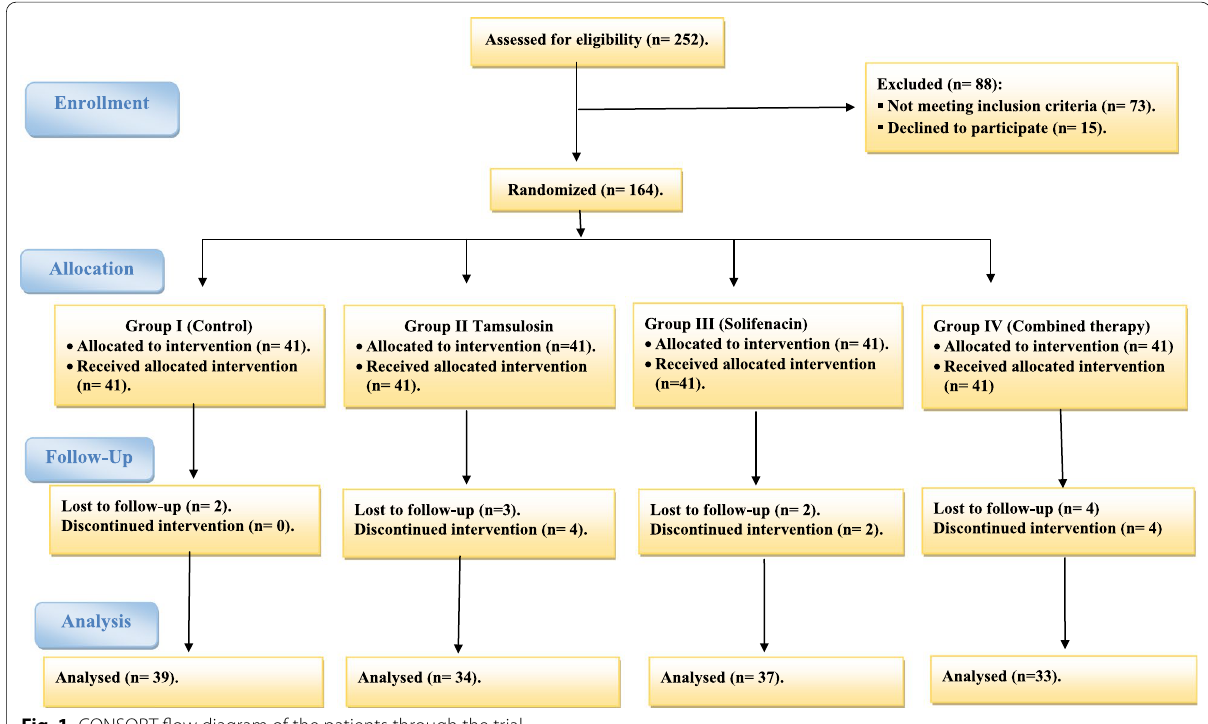
Fig. 1 CONSORT flow diagram of the patients through the trial